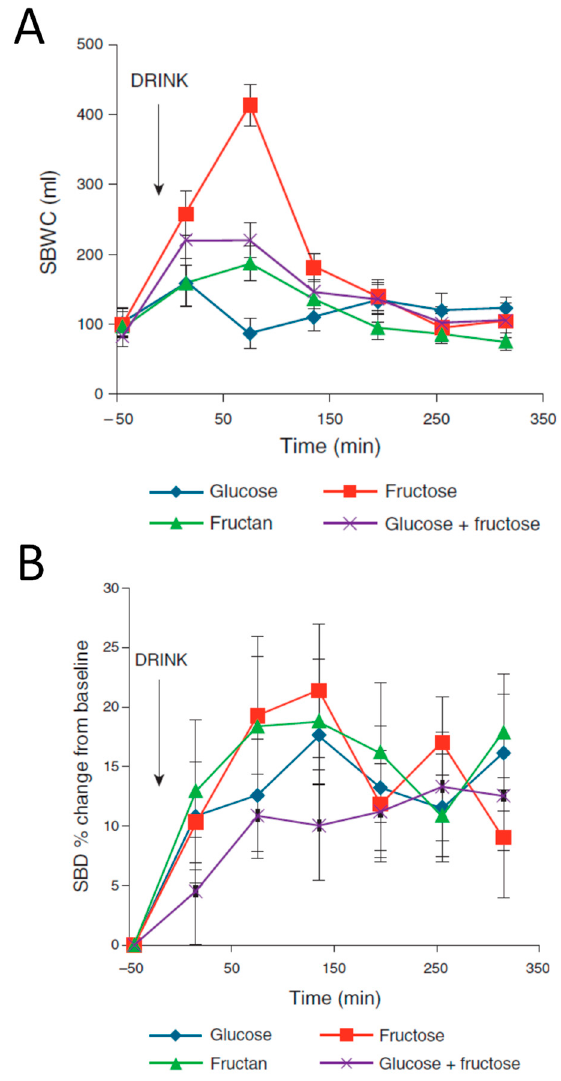
Figure 7. ( A ) Small bowel water content (SBWC) time profile in response to glucose, fructose, fructan and combined fructose drinks. ( B ) Small bowel diameters (SBD) in response to these interventions. Reproduced from [30], Wolters Kluwer Health 2014, with permission.